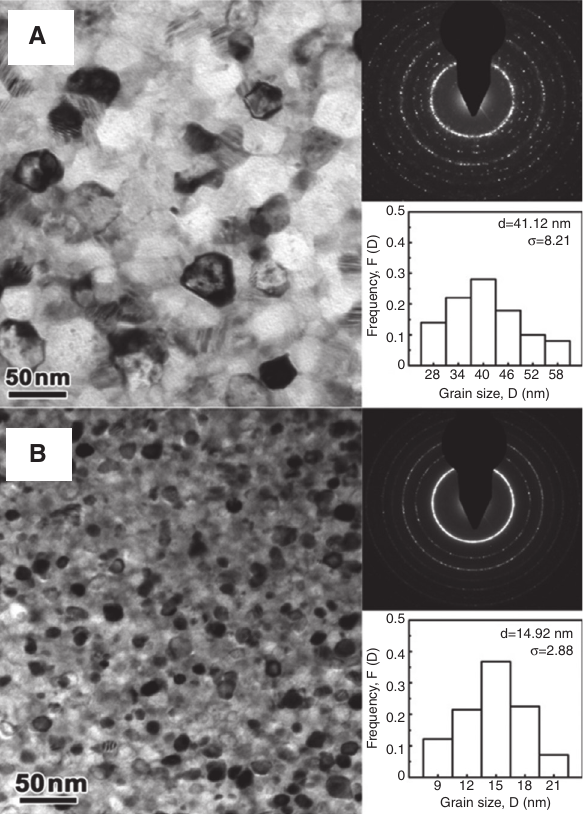
Figure 7 Bright-field TEM images, selected area electron diffraction (SAED) patterns, and distributions of grain sizes of the nanocrystal- line (A) Fe et al. [14], Copyright AIP